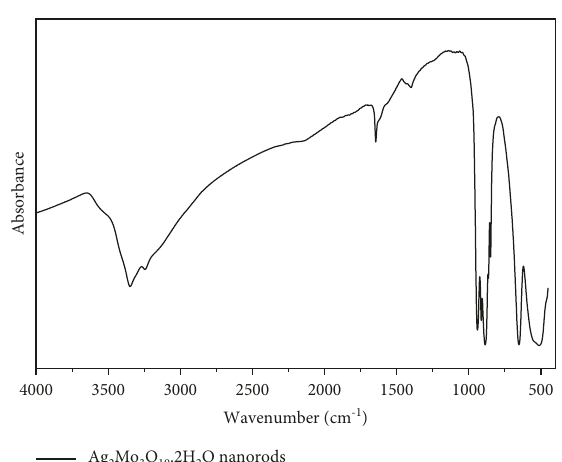
Figure 3: FTIR spectrum of Ag